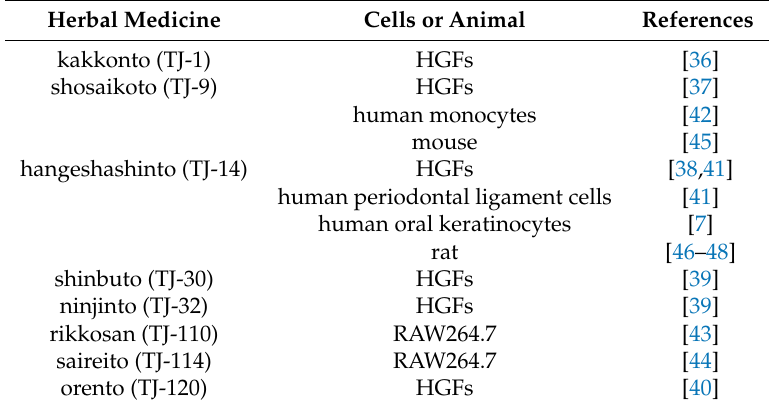
Table 1. Japanese traditional herbal medicines which are reported to reduce PGE 2